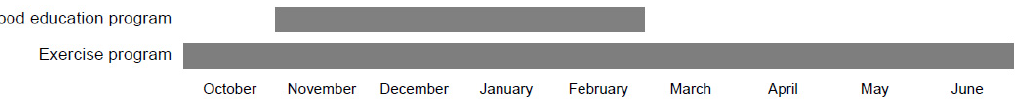
Figure 2. Food education program and exercise program timeline. Table 2. Contents of the food education program.